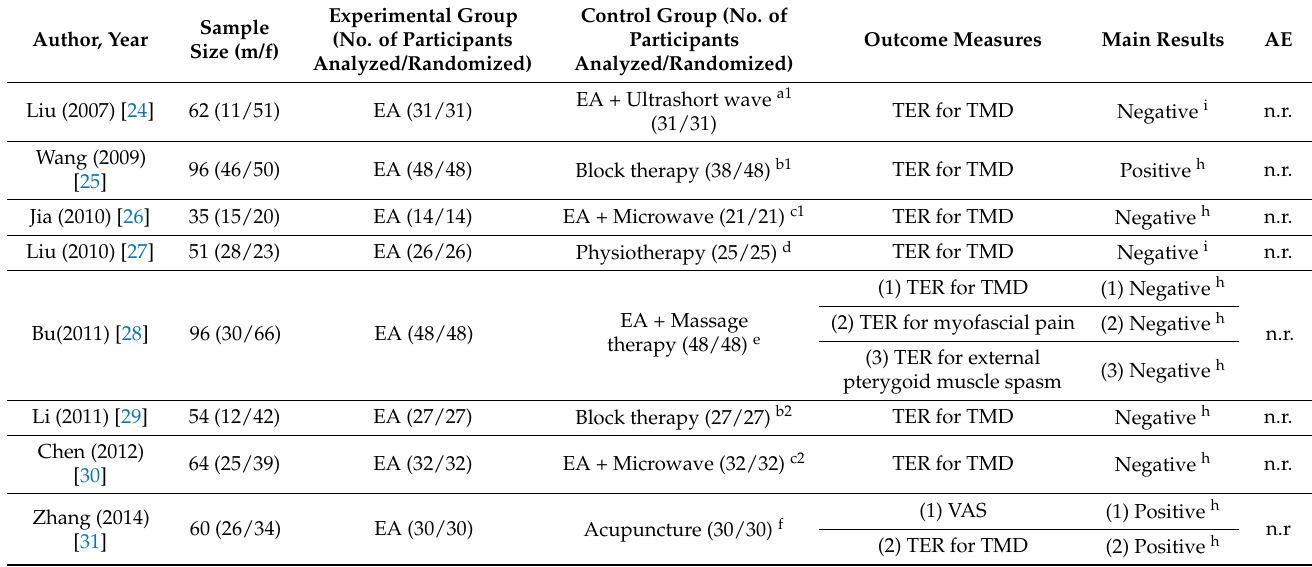
Figure 1. Flowchart of the RCT selection process. CCTs, controlled clinical trials; EA, electroacupuncture; RCTs, randomized controlled trials; TMD, temporomandibular disorders. Table 1. Characteristics of the included